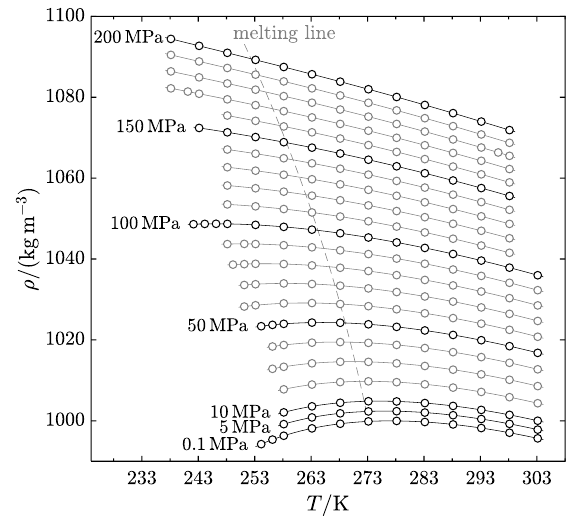
Fig. 2. Density isobars of ordinary water.